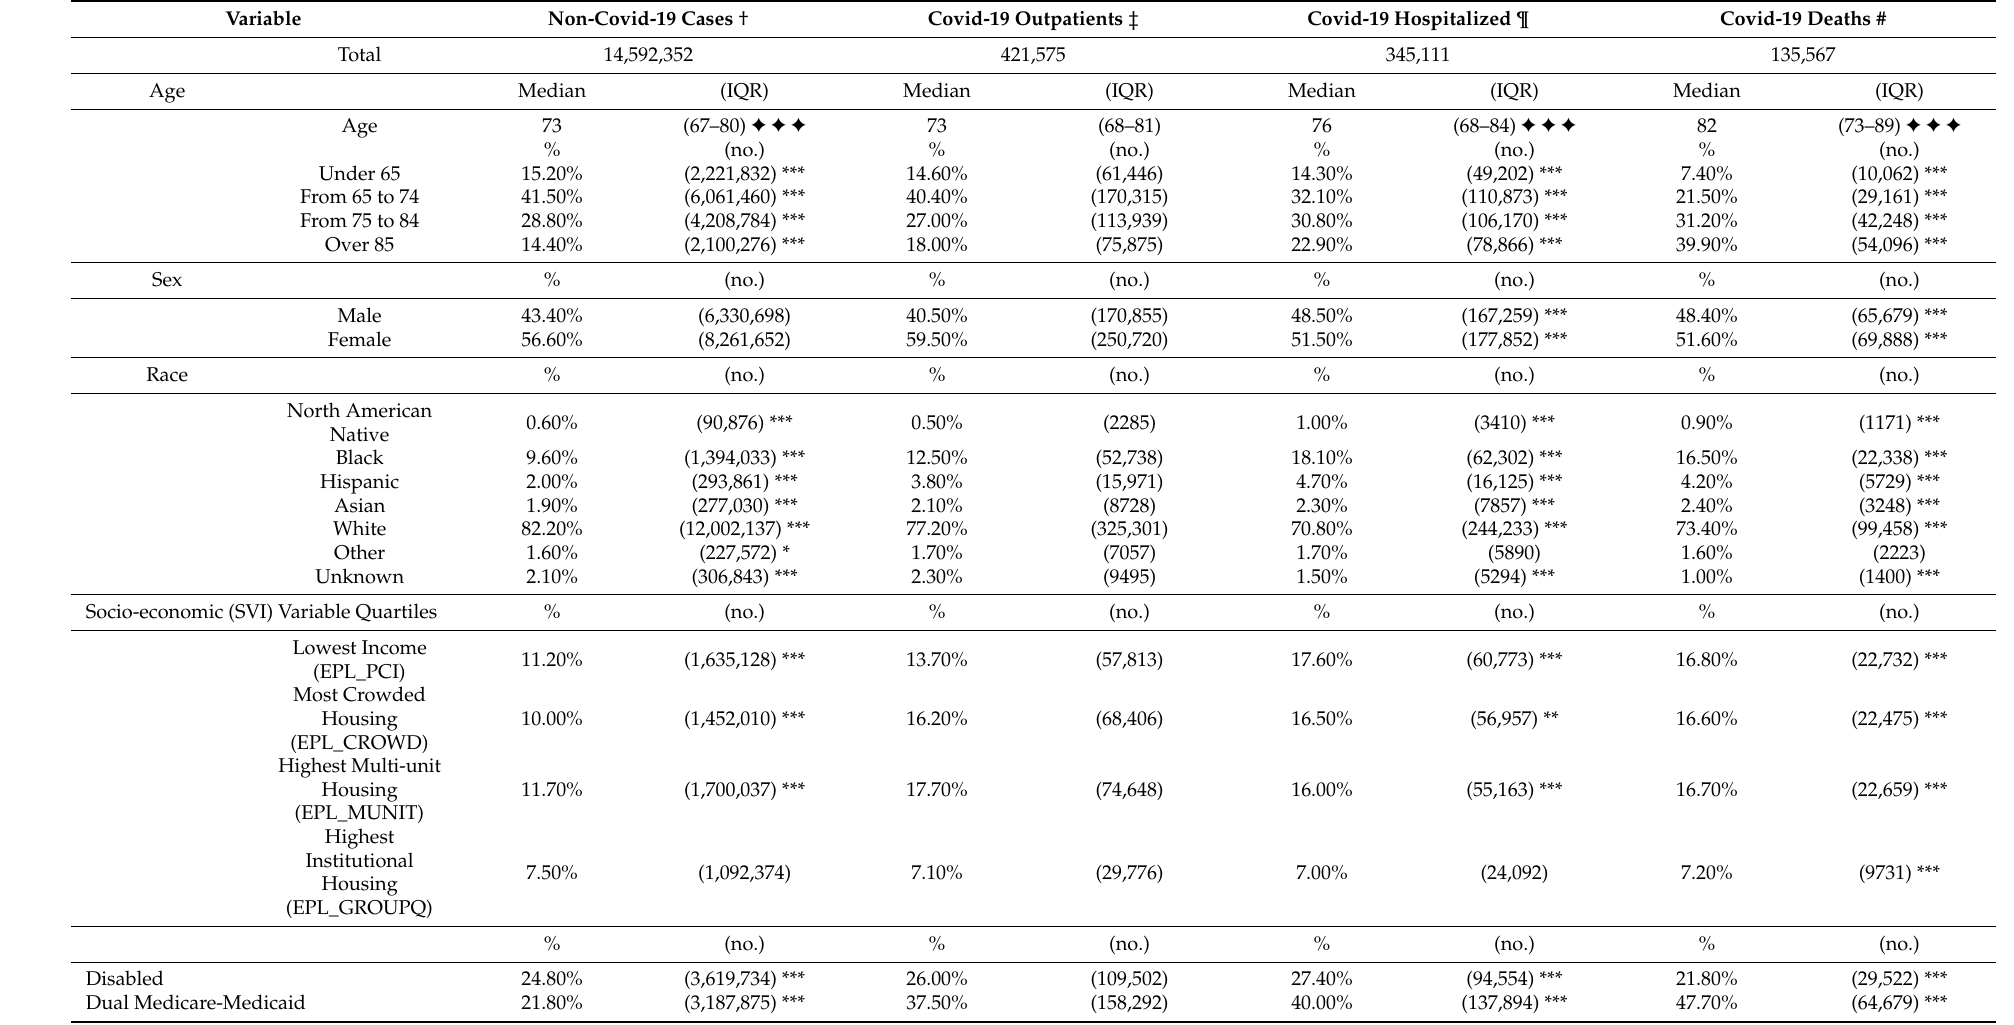
Table 1. Demographic, Clinical and Socioeconomic Characteristics of the Project Salus Medicare Cohort.